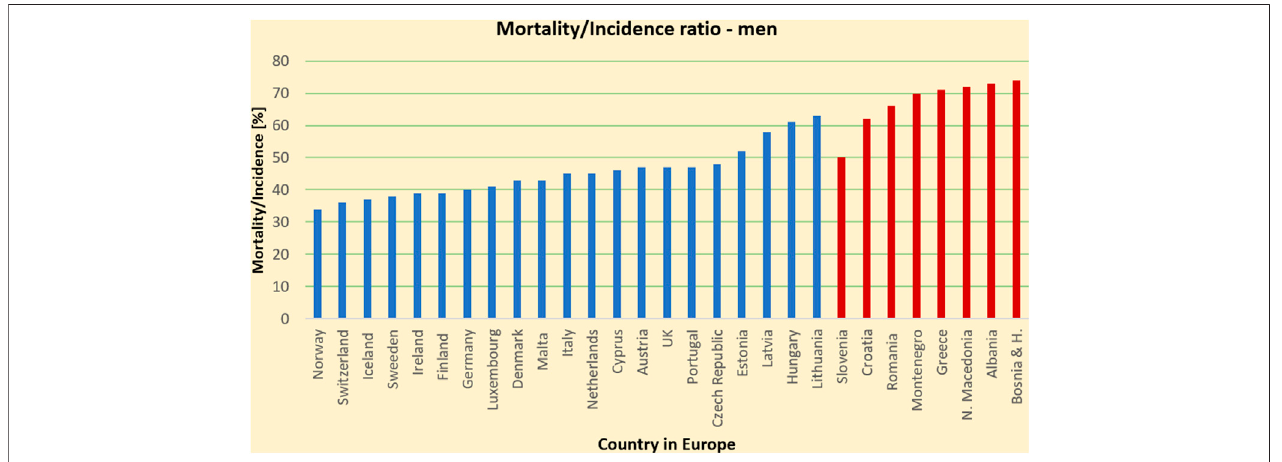
FIGURE 1 | Mortality-to-incidence ratio due to all cancers, all ages, man (2018) for SEE and several Western EU countries for comparison. The image highlights a higher outcome with fatality of the cancer patients in the SEE countries compared to some of the EU